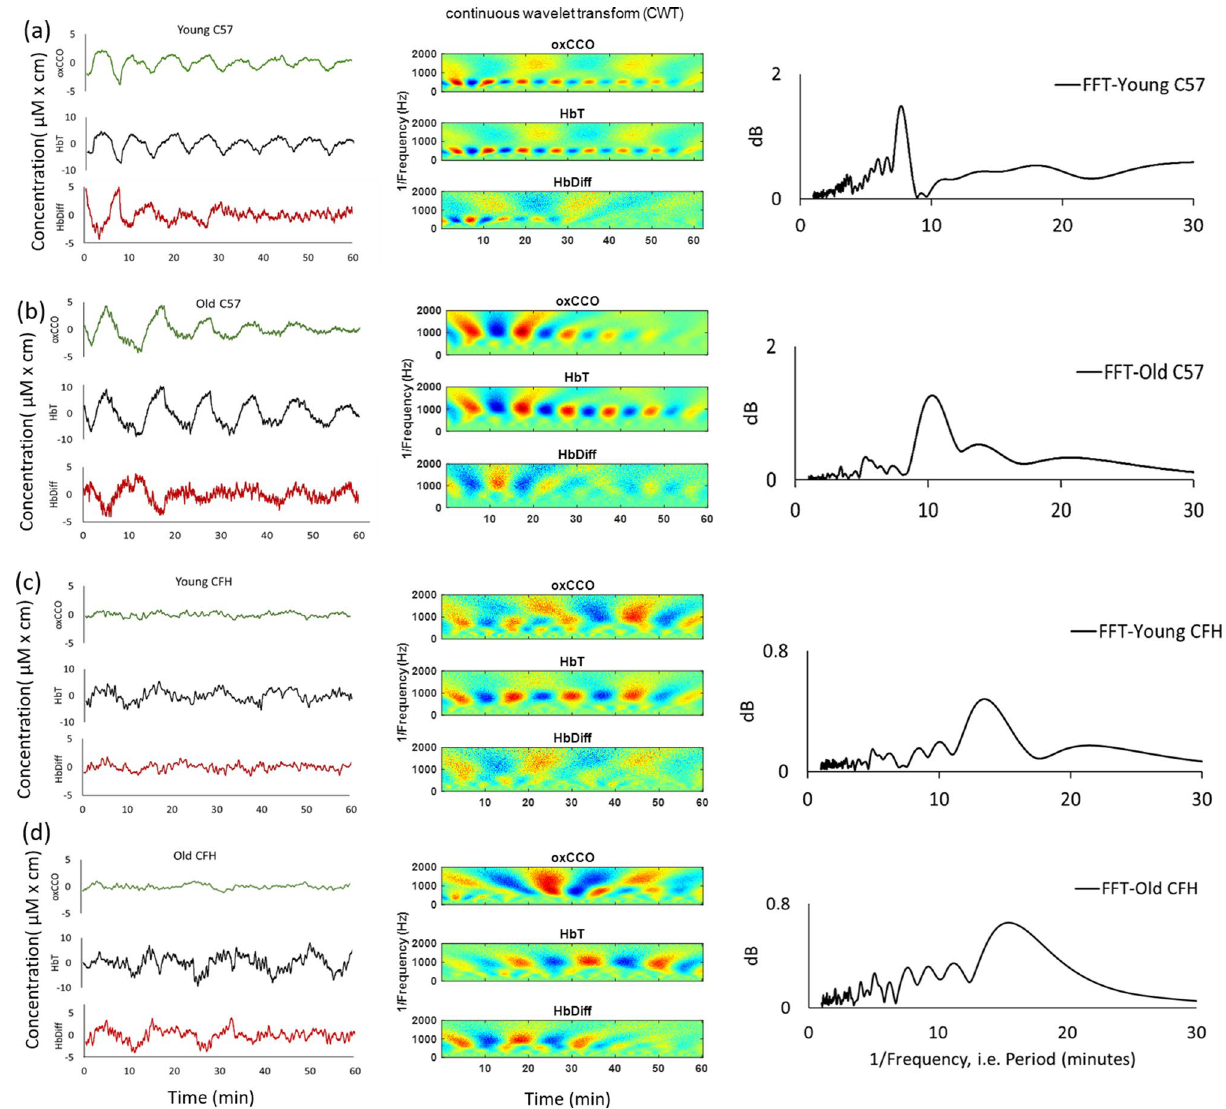
Figure 1. Retinal oscillations are periodic and degrade with age and in CFH −/− . Mitochondrial and blood oscillations in a young C57 ( a ), an old C57 ( b ), a young CFH −/− ( c ) and an old CFH −/− mouse ( d ). In the left column green represents oxidized cytochrome- c -oxidase (oxCCO), black is total hemoglobin (HbT) which is a marker for blood volume being the sum of oxygenated and deoxygenated hemoglobin (HbO 2 and HHb, respectively) and the red represents changes in retinal hemoglobin difference (HbDiff = HbO 2 – HHb) which signifies retinal tissue oxygenation and is sensitive to oxygen delivery. The middle column is complex cross-wavelet transforms (CWT) of the signals in the first column providing the time frequency analysis of mitochondrial (oxCCO) and blood (HbT and HbDiff) signals. The CWT images are produced using a MATLAB program, Comparing Time Series using Semblance Analysis, version 1.0.0.0, found at https :// uk.mathw orks.com/matla bcent ral/filee xchan ge/18409 -compa ring-time-serie s-using -sembl ance-analy sis. Red indicates a positive amplitude and blue a negative. Oscillation regularity in young C57 are revealed with more clearly defined red and blue areas in the CWT images. Mean Fast Fourier Transform of blood and mitochondrial signal oscillations are presented on the right column. The largest peak in the frequency spectrum of each FFT signal provides the most predominant frequency of slow-wave oscillations shown on the left column. These shift to the left running down the column and become less clearly